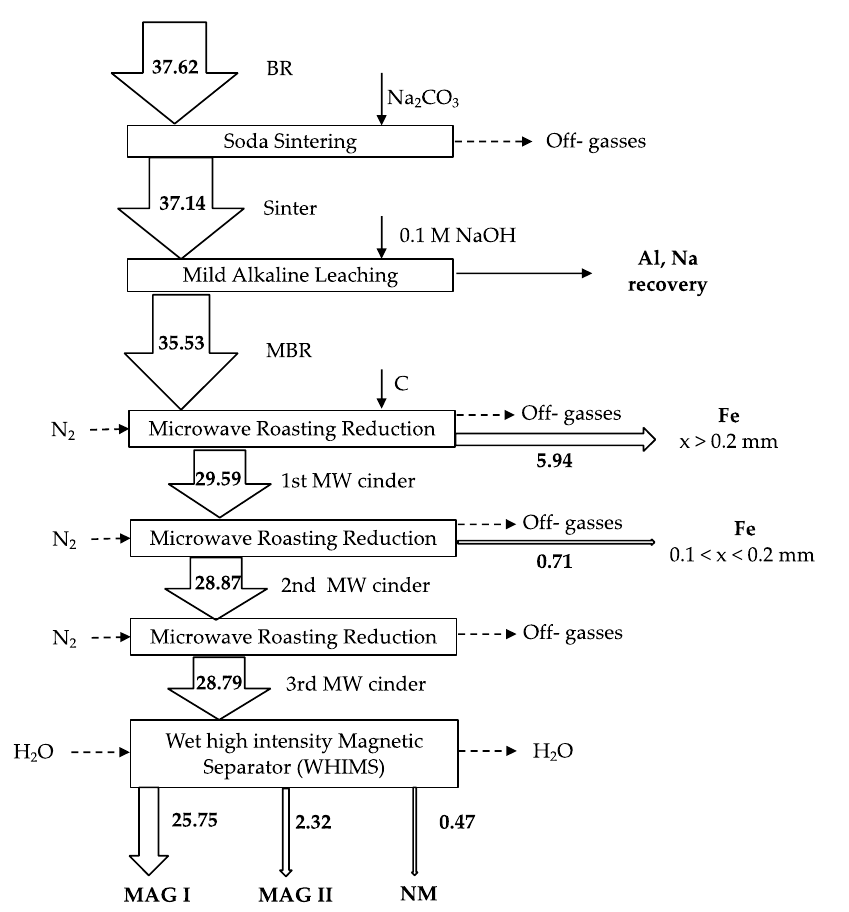
Figure 17. Mass distribution of Fe (g) based on chemical analysis data.